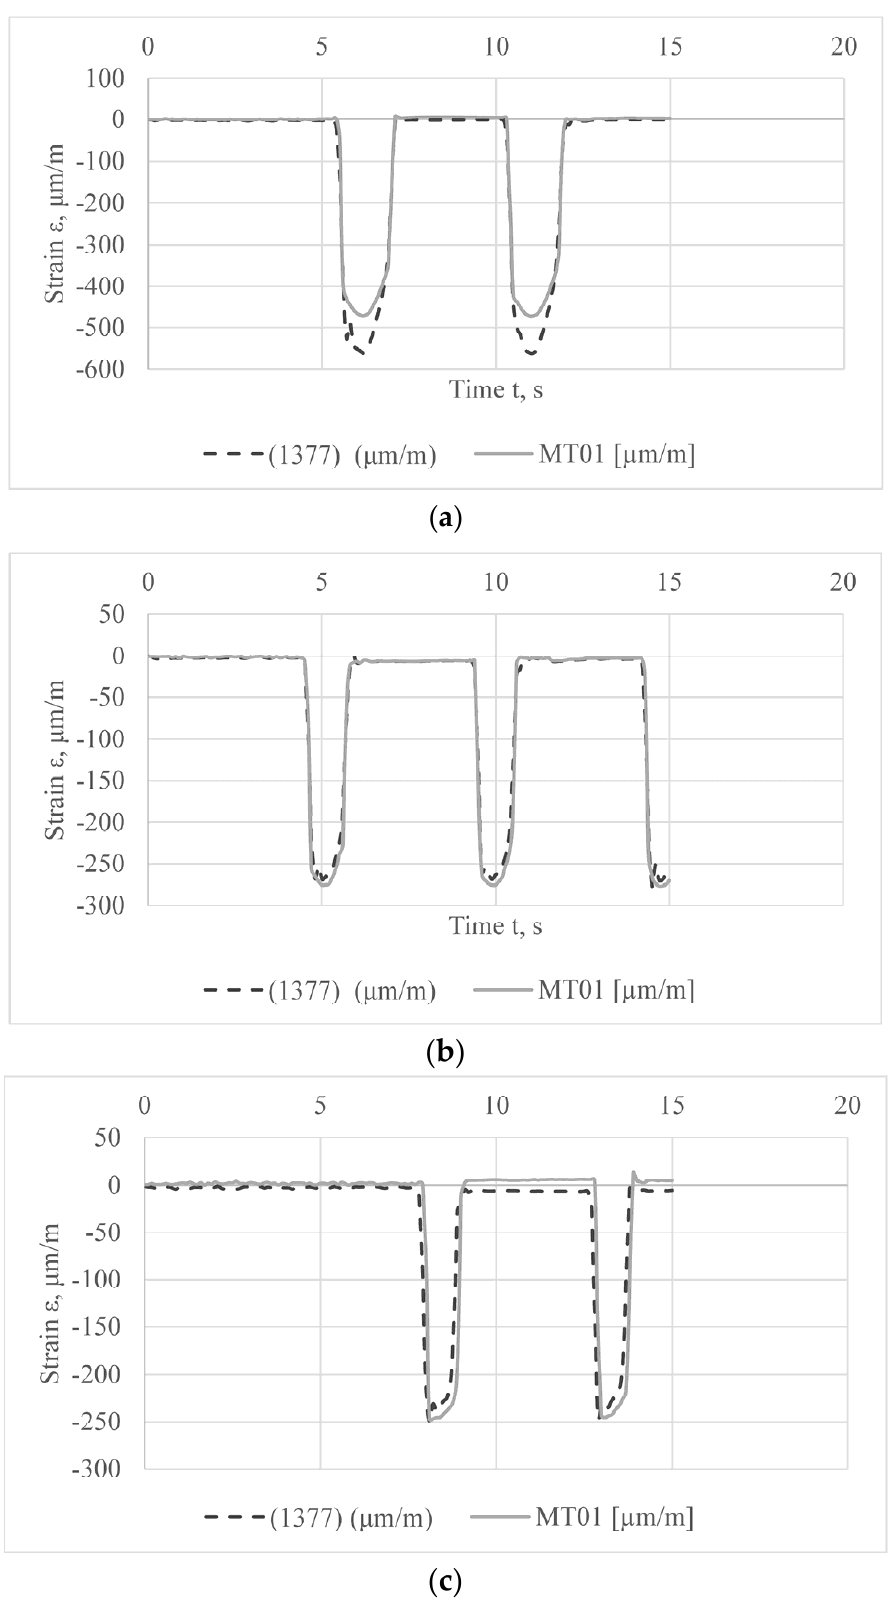
Figure 11. A comparative diagram of the numerical and experimental results obtained at site MT1 (node 1377) at the load of 150% of F N for ( a ) single–tooth meshing; ( b ) double–tooth meshing, and ( c ) triple–tooth meshing.